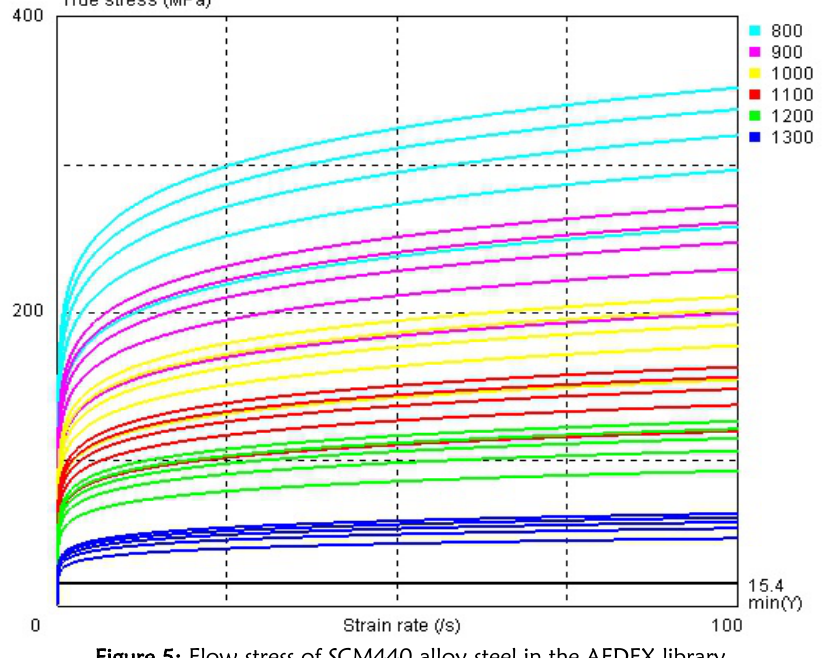
Figure 5: Flow stress of SCM440 alloy steel in the AFDEX